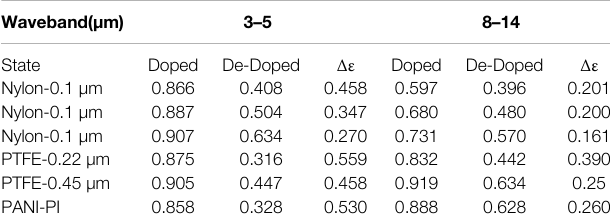
TABLE 1 | The average emissivity and IR modulation value of PANI fi lms on the different substrates in 3 – 5 μ m and 8 – 14 μ m, respectively. Copy right from Lu et al.